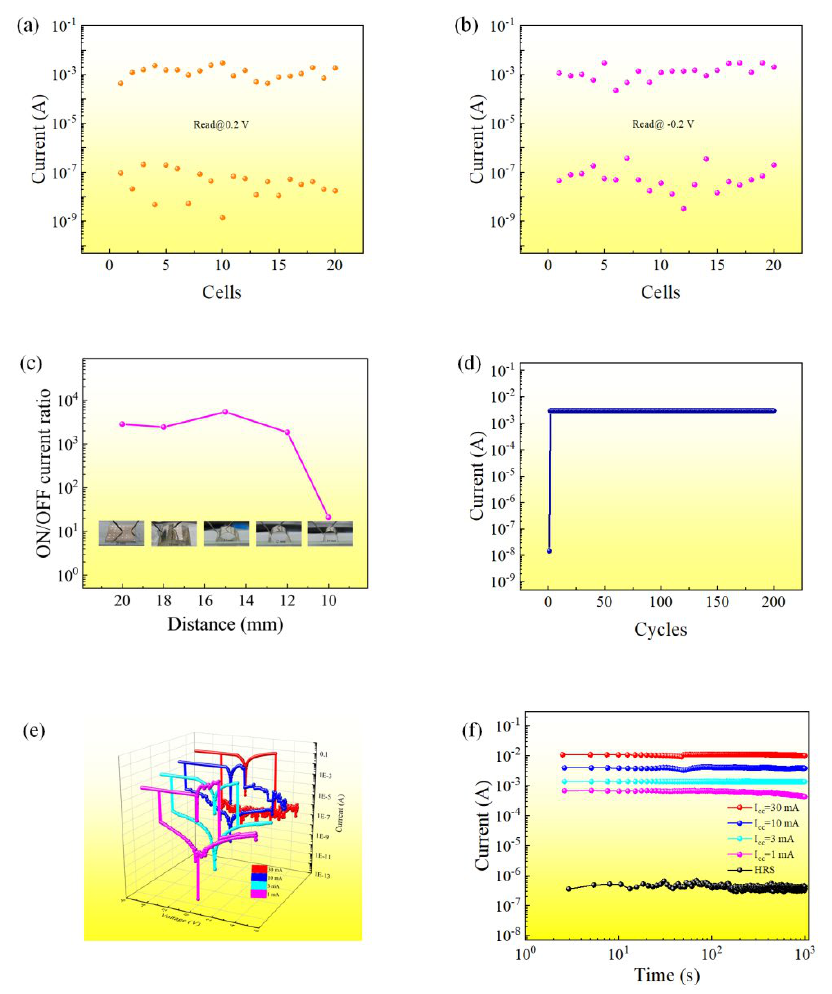
Figure 3. Current value for HRS and LRS of 20 cells of Al/EA:Ag + /ITO ( a ) read voltage is − 0.2 V ( b ) read voltage is 0.2 V. ( c ) Bending stability of the Al/EA:Ag + /ITO device. ( d ) Switching of the Al/EA:Ag + /ITO device cycle; the current value is read at −0.5 V. Multilevel test results of the Al/EA:Ag + /ITO device: ( e ) typical I–V characteristic curve and ( f ) retention time.